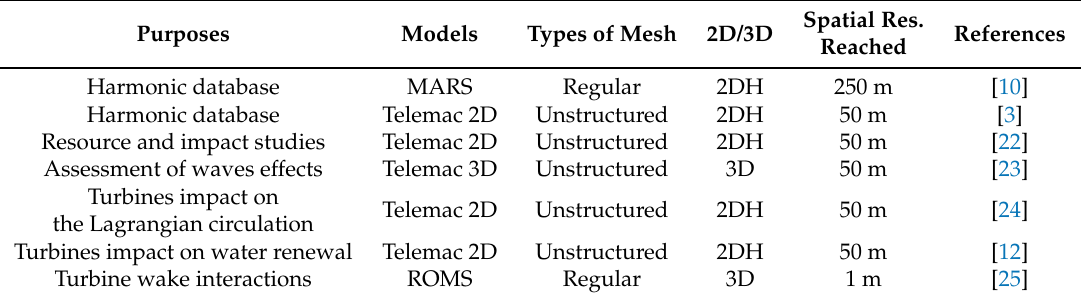
Table 2. Hindcast databases and numerical simulations exploited to characterize the tidal stream energy resource of the Fromveur